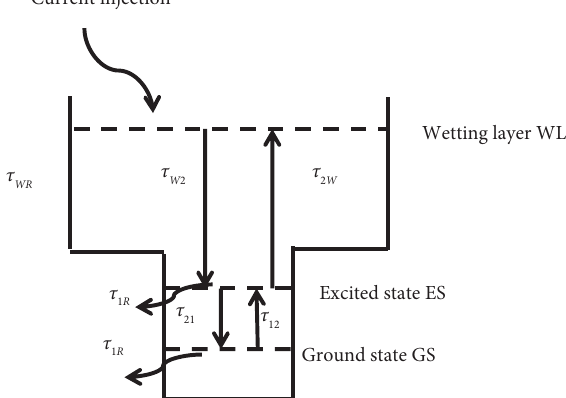
Figure 3: Schematic diagram of the energy band of TlBr